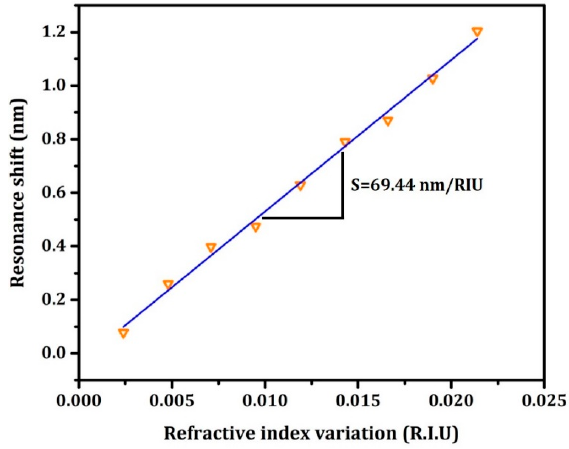
Figure 10. The linear curve of the relationship between resonance shifts is relative to changes in the environmental refractive index and sensitivity of the sensor based on MRR .